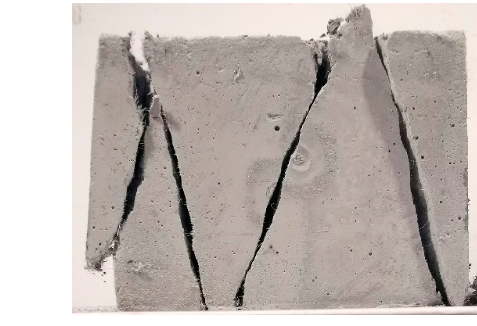
Figure 2. Typical uniaxial failure mode (C0T4-1) (lateral pressure level C = 0, strain rate s − 1 ).